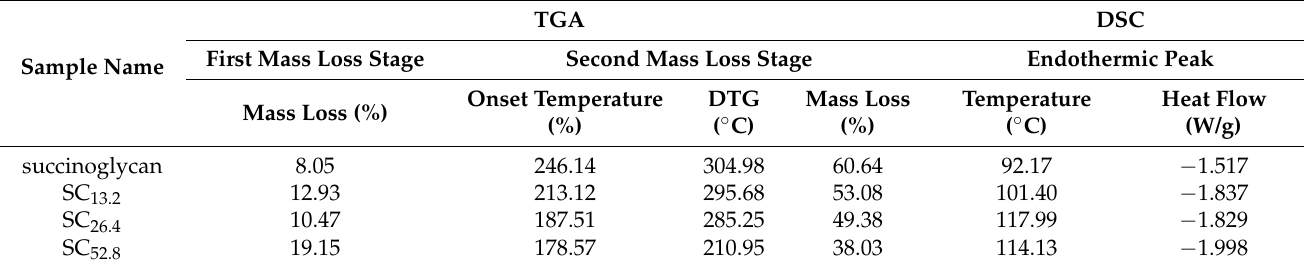
Figure 6. Comparison of the thermal analysis for SCx with respect to different Cr 3+ concentrations: ( a ) thermogravimetric analysis (TGA) and ( b ) differential scanning calorimetry (DSC). Table 2. Thermal properties of metallohydrogels.